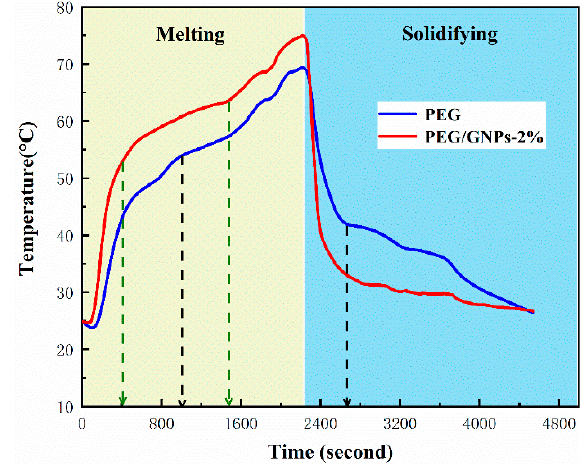
Figure 8. Heating and cooling ‐ rate curves of pure PEG and PEG/GNPs ‐ 2% composites.